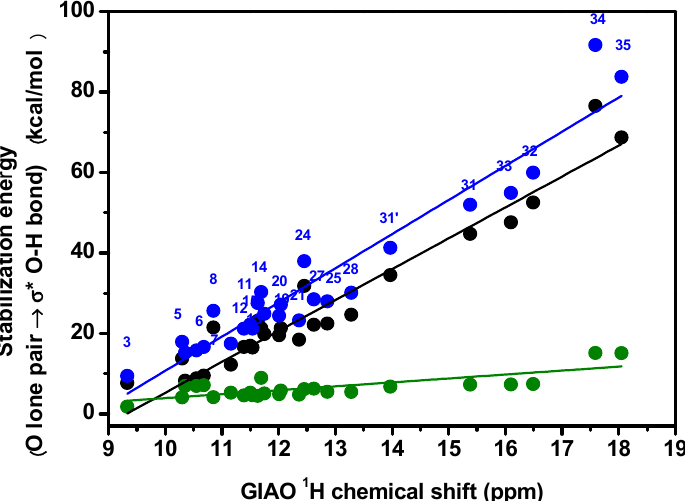
Figure 15. Calculated, at the GIAO DFT/B3LYP/6-311+G(2d,p) level of theory with CPCM in CHCl 3 , chemical shifts of the compounds of Figure 9 with minimization of structures at the M06-2X/6-31+G(d) level of theory) vs. stabilization energy (Second Order Perturbation Theory Analysis) between the lone pairs of the oxygen of the carbonyl group with the σ * antibonding orbital of the H-O bond) (lone pair 1 in black, R 2 = 0.946, lone pair 2 in green, R 2 = 0.575, and the sum in blue, R 2 = 0.921). Reprinted, with permission, from [47]. Copyright 2015, The Royal Society of Chemistry.